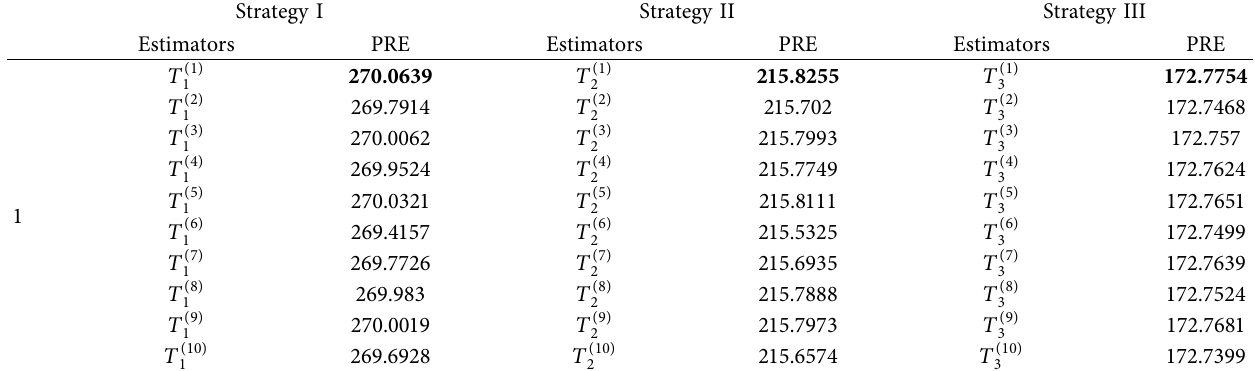
Table 5: Data summary for Population-III and -IV.